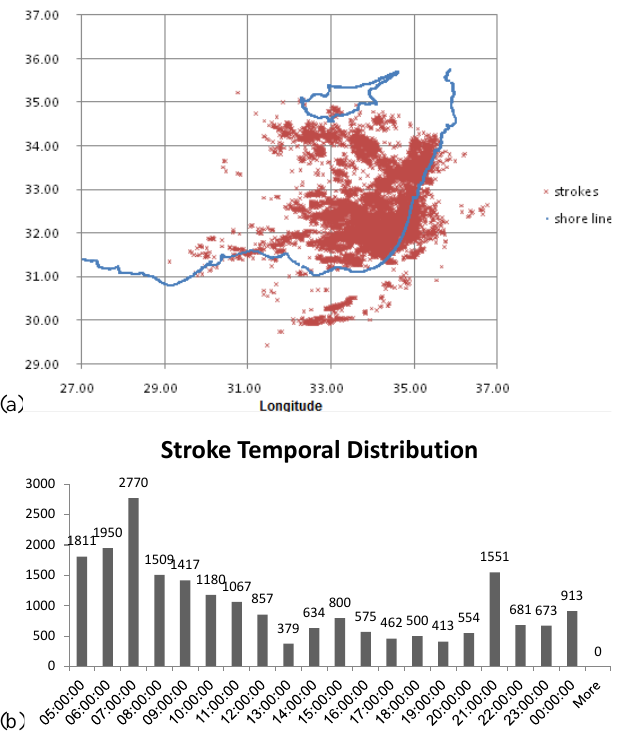
Fig. 6. (a) The distribution of strokes for the storm of 30.10.2009. (b) The temporal distribution of strokes along the day.